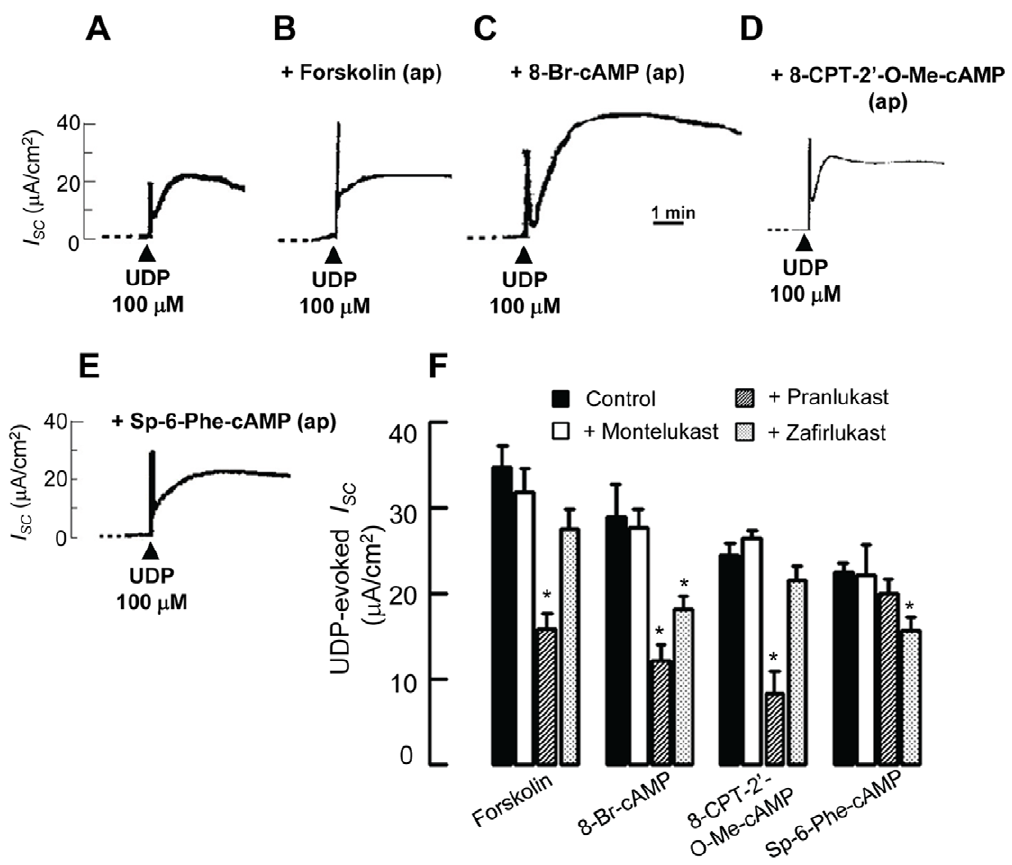
Figure 5. Inhibition by CysLT 1 receptor antagonists of the potentiating effect of cAMP and Epac on UDP-evoked I SC . Representative recordings of I SC showing the response to the apical application of 100 m M UDP alone (A) or in combination with pretreatment of the epithelia with 1 m M forskolin (B), 8-Br-cAMP (C), 8-CPT-2 9 - O -Me-cAMP (D), or Sp-6-Phe-cAMP (E) 10 min prior to the application of UDP. (F) Summarized data showing the potentiating effect of cAMP or Epac on UDP-evoked I SC could be inhibited by different CysLT 1 receptor antagonists. Control refers to the I SC responses of the epithelia to UDP in the presence of various potentiating agents. Each column represents the mean 6 S.E. ( n =4–6). (*, p , 0.05, one-way ANOVA with Bonferroni post-hoc test compared with control).